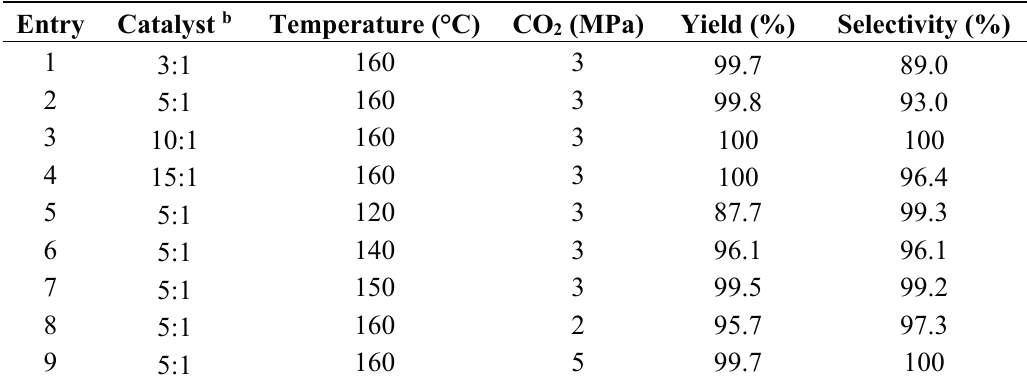
Table 2. Performance of BIm-based nanogel catalyst for the cycloaddition reaction of CO 2 with ECH in different temperature a